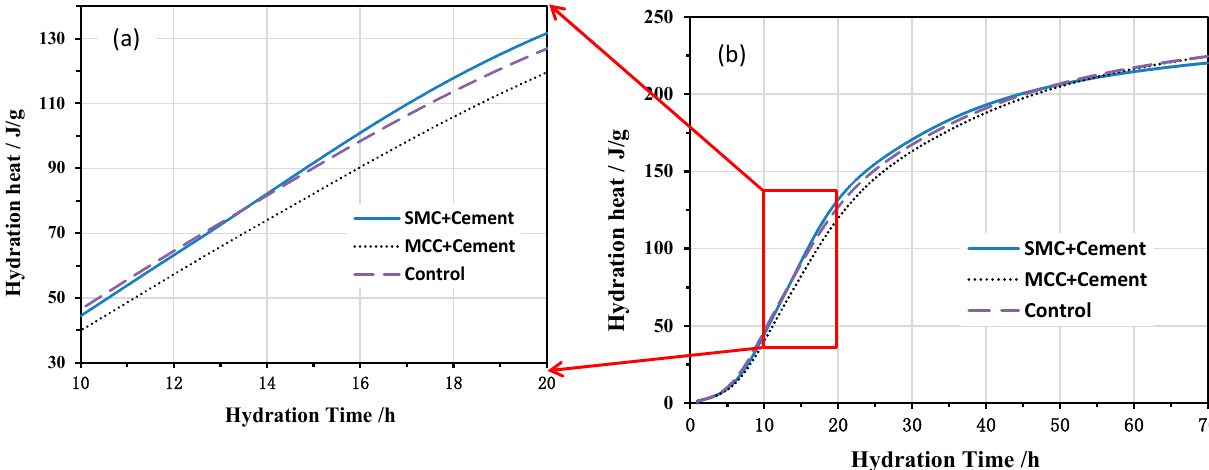
Figure 4. Accumulated heat of hydration for different pastes during ( a ) from 10 to 20 h and ( b ) the first 70 h.